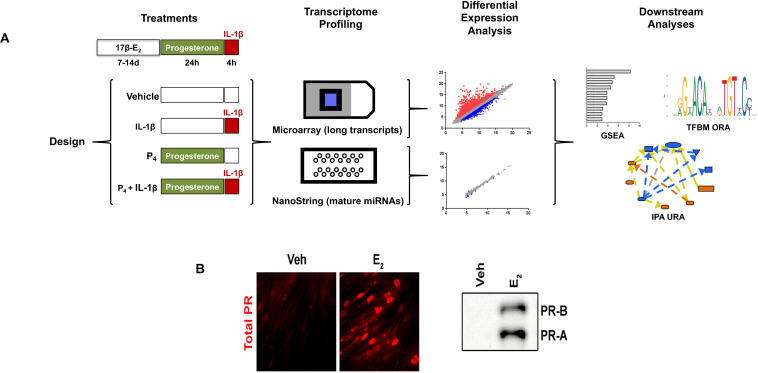
Experimental design and workflow. (A) Primary cultures of cervical fibroblasts were primed with 10–8 M 17β-estradiol (17β-E2) or 0.001% ethanol vehicle for 7–14 days in F12/DMEM++0.5% charcoal-stripped FBS. Cells were then treated with 10–7 M progesterone (P4) or vehicle for 24 h followed by a 4-h stimulation with 0.2 ng/ml interleukin-1β (IL-1upbeta) or vehicle (PBS/0.1% BSA). Total RNA was extracted to enrich for small RNAs and subjected to microarray analysis using the Affymetrix platform for long, coding transcripts and the NanoString® platform for small, non-coding RNAs. After normalization, the data were subjected to differential expression analysis was conducted using the Affymetrix Transcription Analysis Console. Downstream relationships were evaluated using Gene Set Enrichment Analysis (GSEA), Transcription Factor Binding Motif (TFBM) analysis, and Ingenuity Pathway Analysis. The relative expression data are the mean and FDR p-value from three separate sets of biological replicates. (B) depicts the expression of PR-A and PR-B using immunofluorescence (left panel) or immunoblotting (right panel) following priming with 17β-E2.